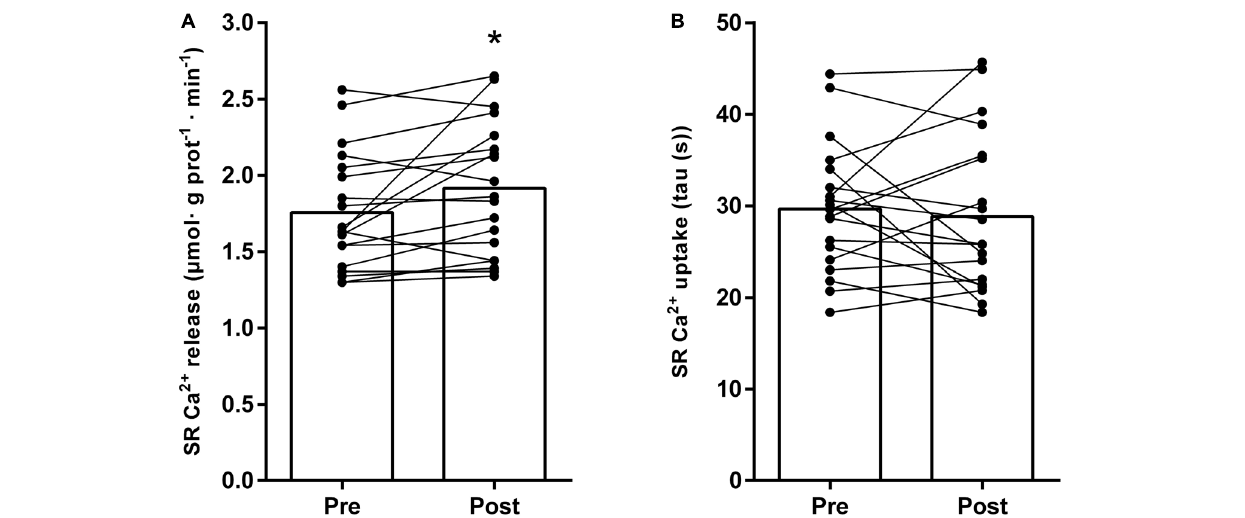
FIGURE 5 | Changes in SR vesicle Ca 2 + release rate (A) and SR Ca 2 + uptake (B) , measured as the time for free [Ca 2 + ] to decrease by 63%, during 4 weeks of endurance training in highly trained endurance athletes ( n = 19). The training period included a mixture of low-, moderate-, and high-intensity exercise – see section “Materials and Methods” for details. Both individual and mean changes are shown. * different from pre, P =